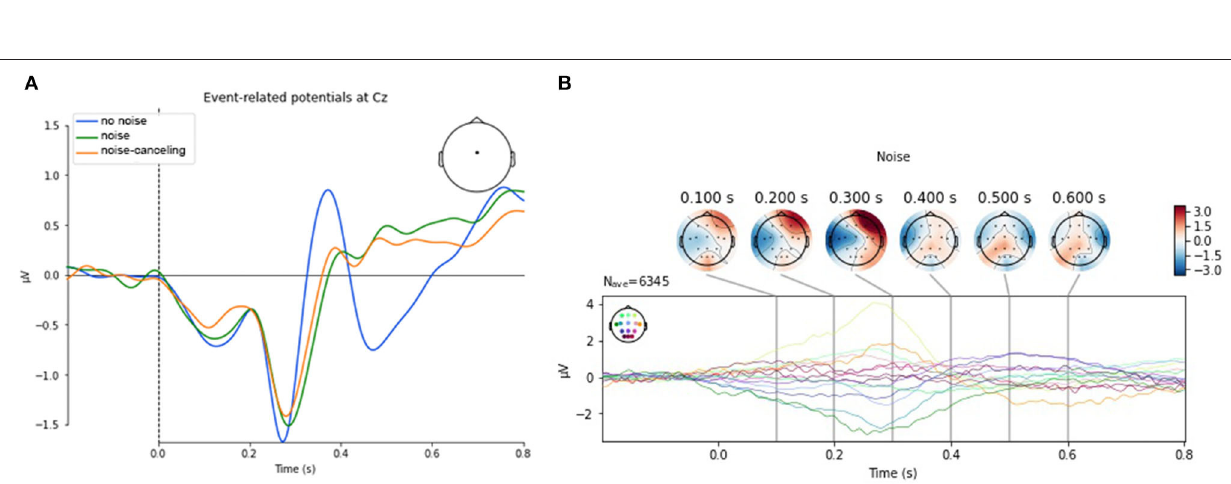
FIGURE 5 | (A) Event-related potentials at Cz. The characteristic signal course of component of P300 the amplitude is higher in no noise compared to the other two conditions. (B) Topography plot of event-related potentials aggregated from all sensors exemplary for the noise condition. Sensor positions are color-coded. The activity range is given from − 3 to 3 µ V . After 400 ms after stimulus, the activation is increasingly prominent at the centro-parietal area of the scalp that indicates a P300